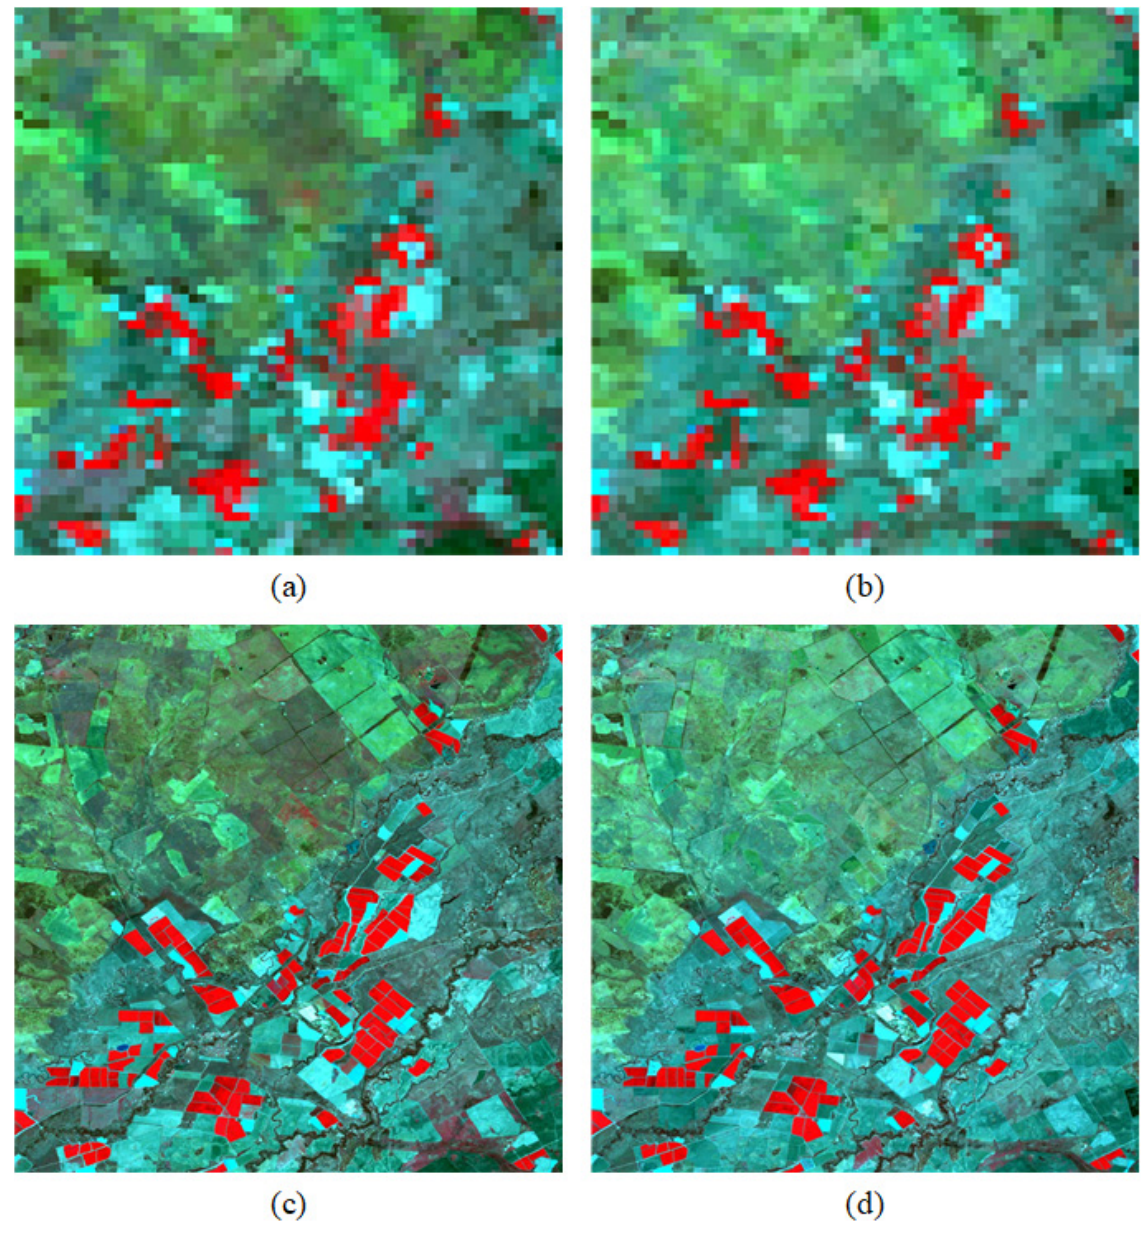
Figure 5. Composite MODIS ( top row ) and Landsat ( bottom row ) image pairs on 29 January ( a , c ) and 14 February ( b , d ) 2005 from the LGC [44] dataset. The LGC dataset focuses on changes in land cover types after the flood.